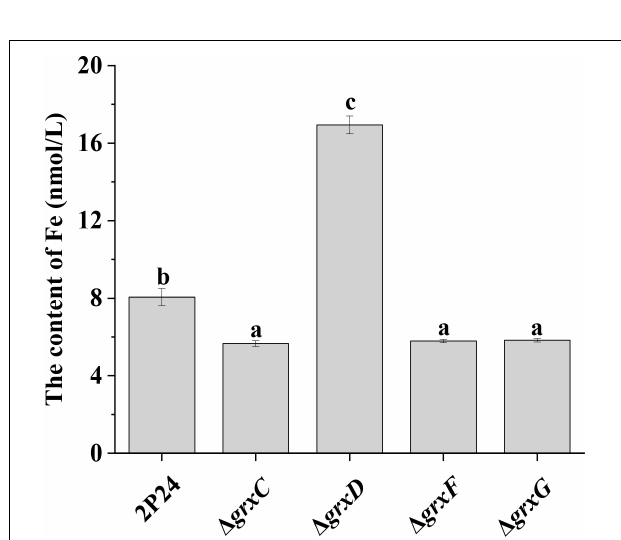
FIGURE 7 | Deletion of grx genes influenced the iron content of Pseudomonas fluorescens . The Fe content was measured in 3 × 10 9 cells of strain 2P24 and its derivatives using the ferrozine assay. The experiment was performed in triplicate, and different letters indicate a significant difference at the 0.05